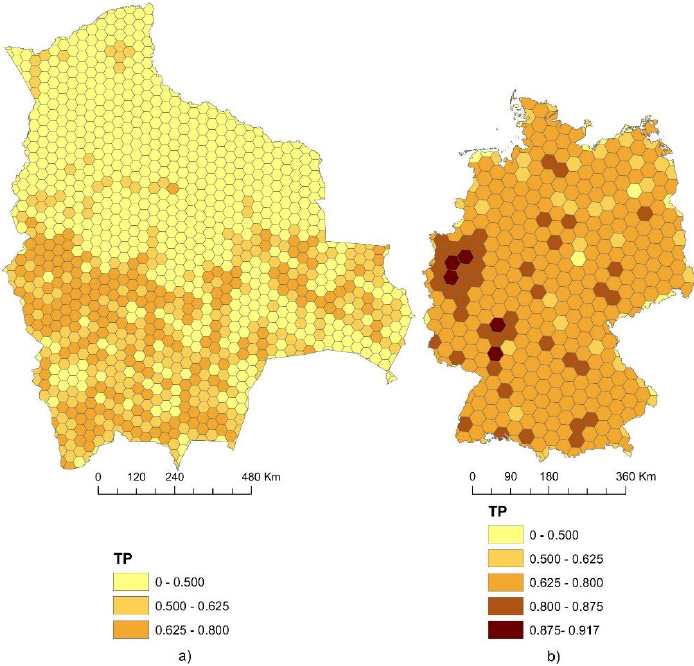
Figure 10. The level of transport provision of the territory ( a ) for Bolivia and ( b ) for Germany. Table 2. Comparative characteristics of the calculation of transport development of a territory.